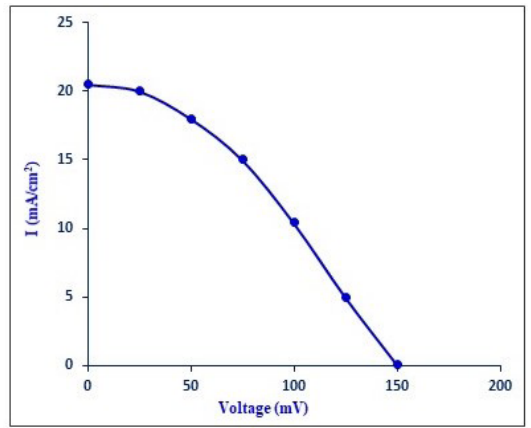
Zn Se photoelectrode. 0.5 0.5